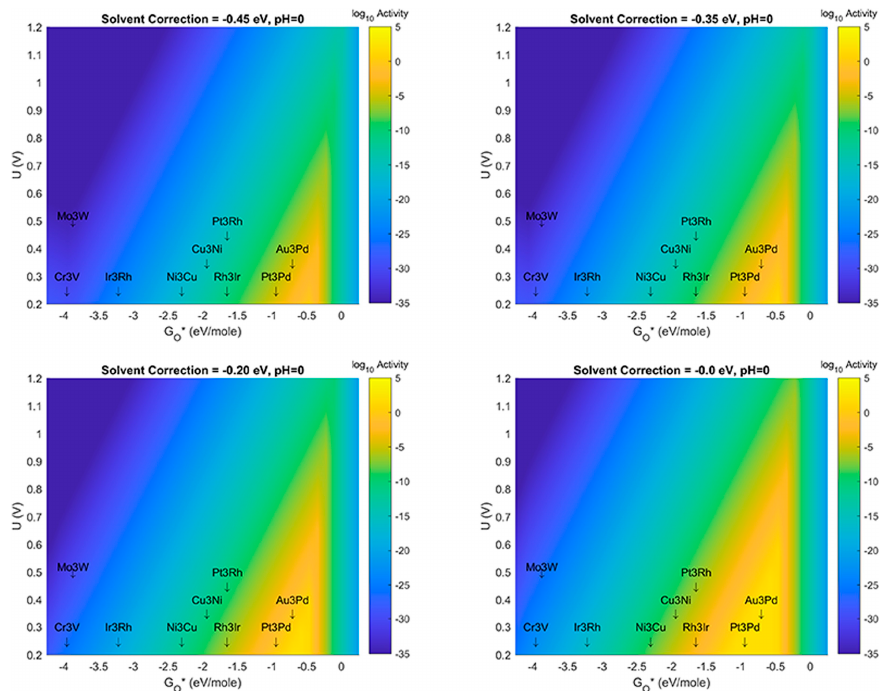
Figure 9. Volcano Plot analysis for ORR activity at solvent correction value of − 0.00 eV (no solvent correction to free energy of system). Top left (pH = 0), Top right (pH = 1), Bottom left (pH = 3), Bottom Right (pH = 7). Blue denotes lowest activity, yellow denotes highest activity. All plots use same color- axis scale hence some saturation at maximum activity and minimum activity. Activity given in log10 scale to show more detail in plot.